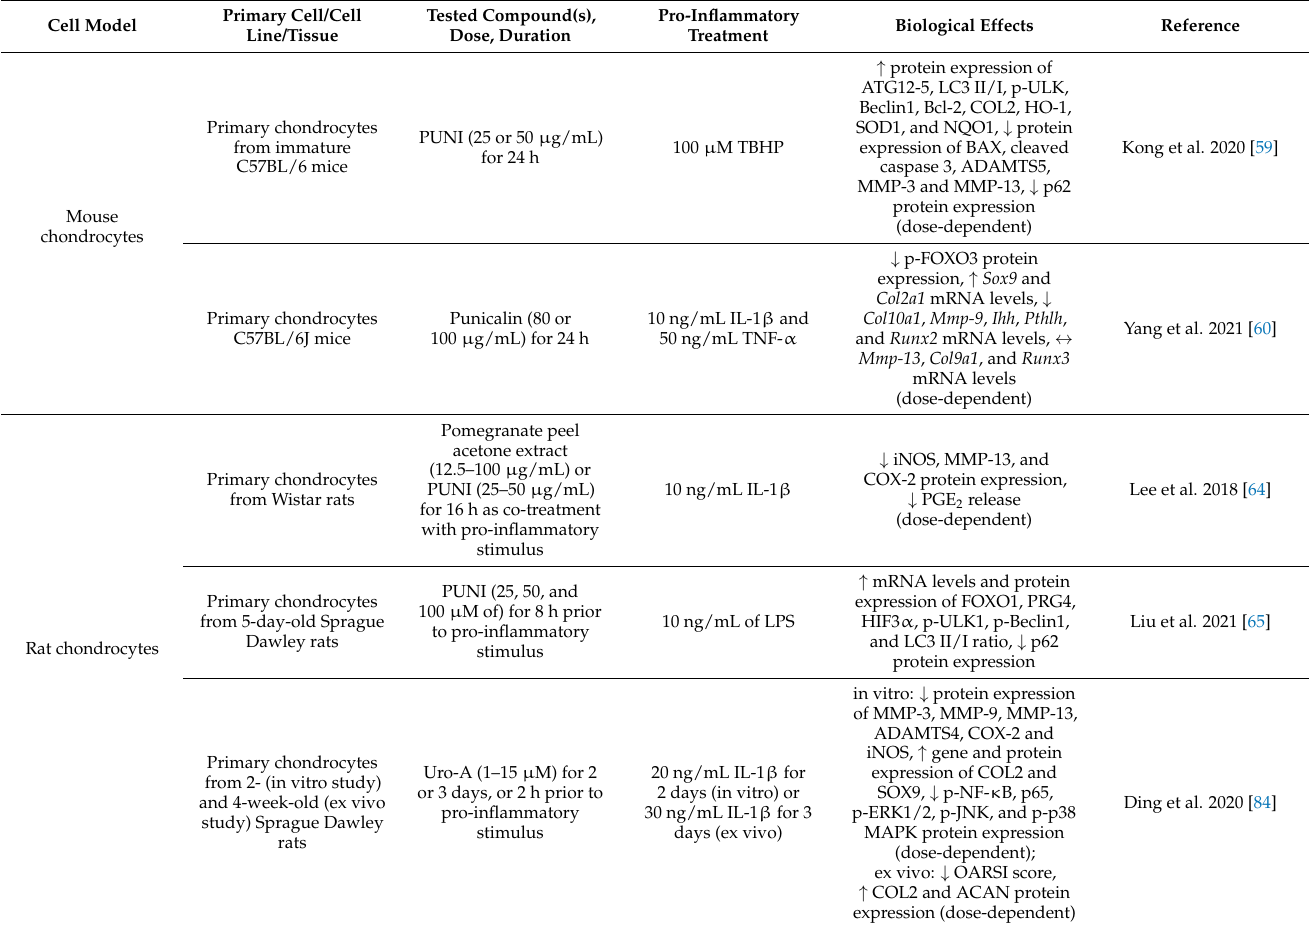
Table 4. Summary of the biological effects of HTs or HT-derived metabolites assayed in cell culture studies (see Table S1 for specific details on sample preparation and characterization of the tested